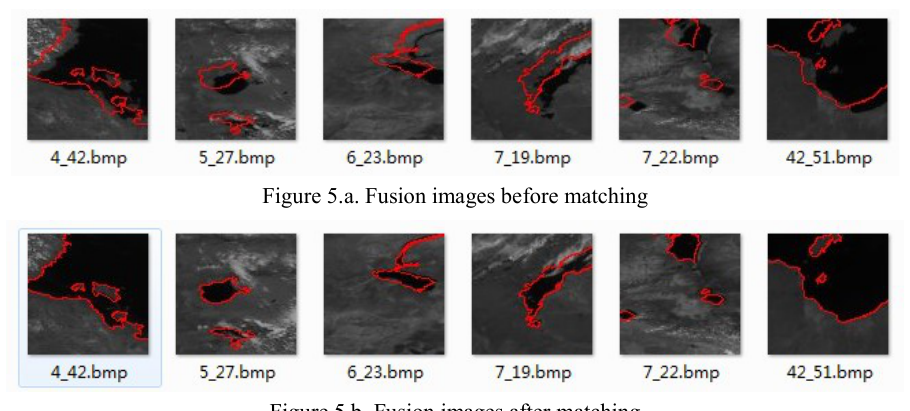
Figure 5.b. Fusion images after